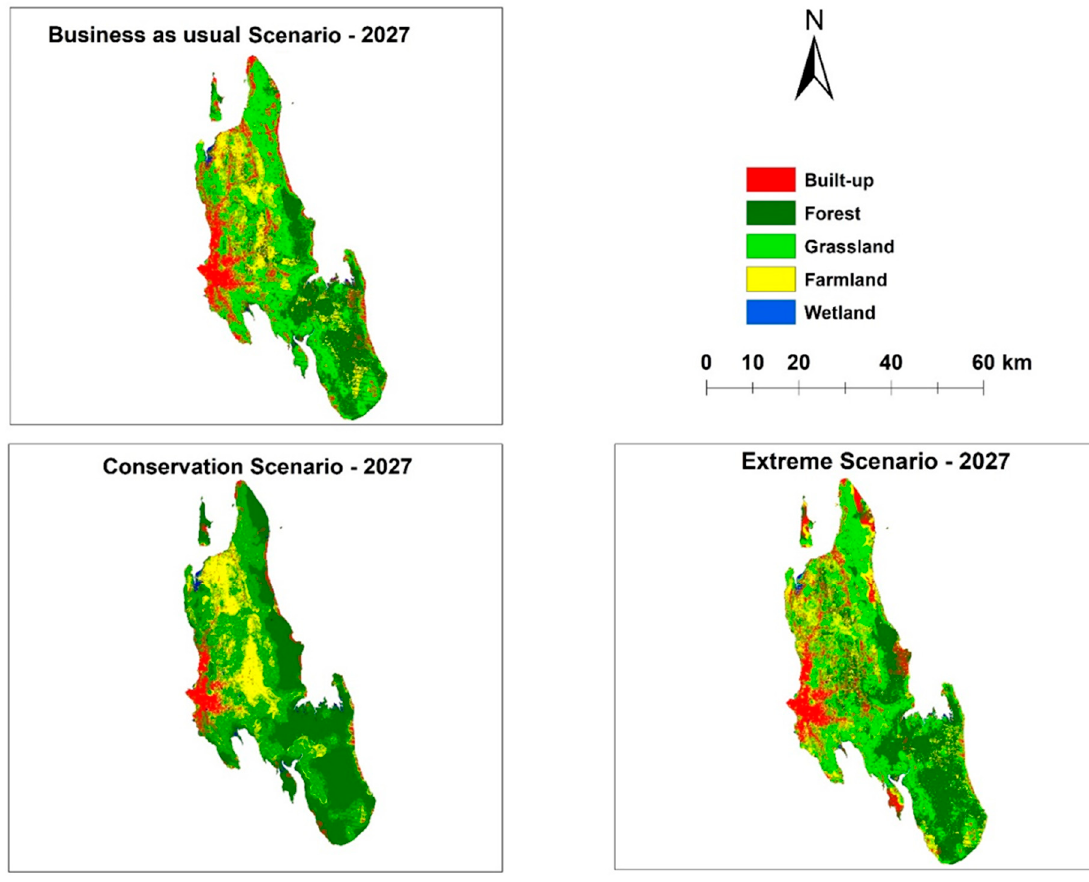
Figure 8. Simulated Land Use Land Cover maps for 2027. Remote Sens. 2020 , 12 , x FOR PEER REVIEW 17 of 25